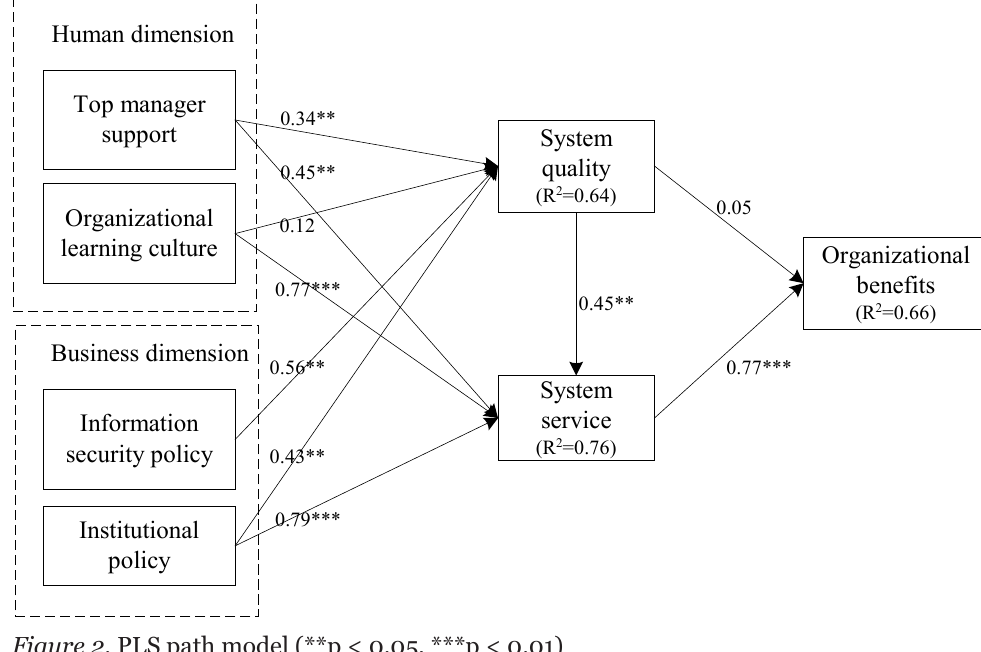
Figure 2. PLS path model (**p < 0.05, ***p < 0.01)